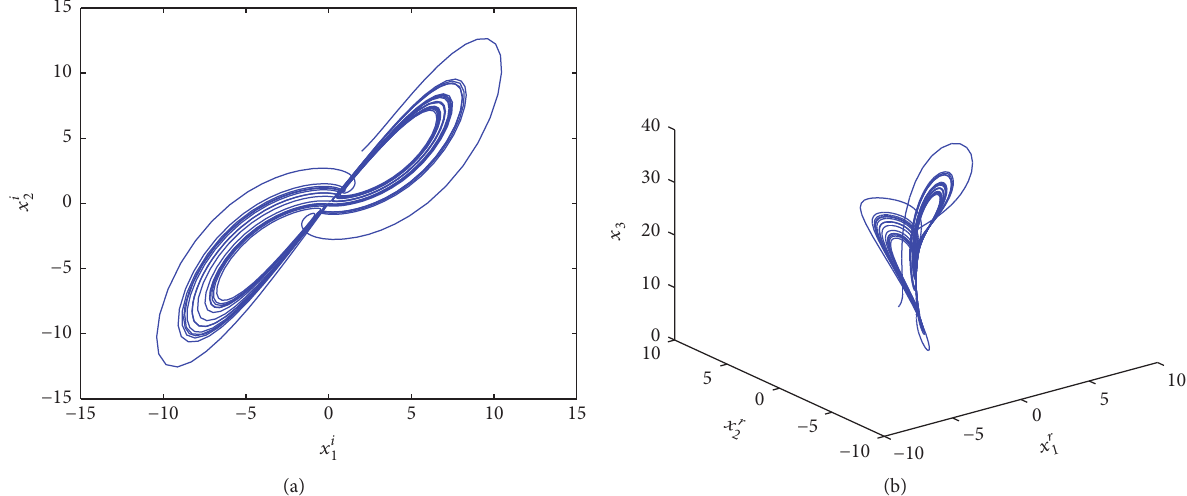
Figure 2: Chaotic behavior and attractors of the complex PMSM system (3) in different phase planes and projections.